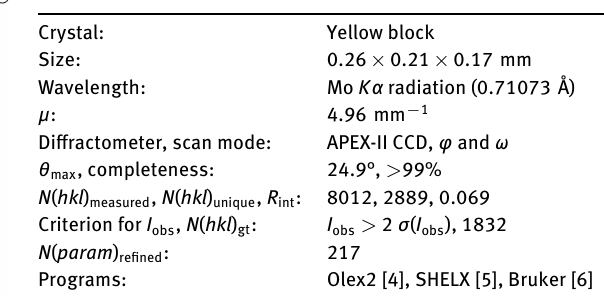
Table 1: Data collection and handling.